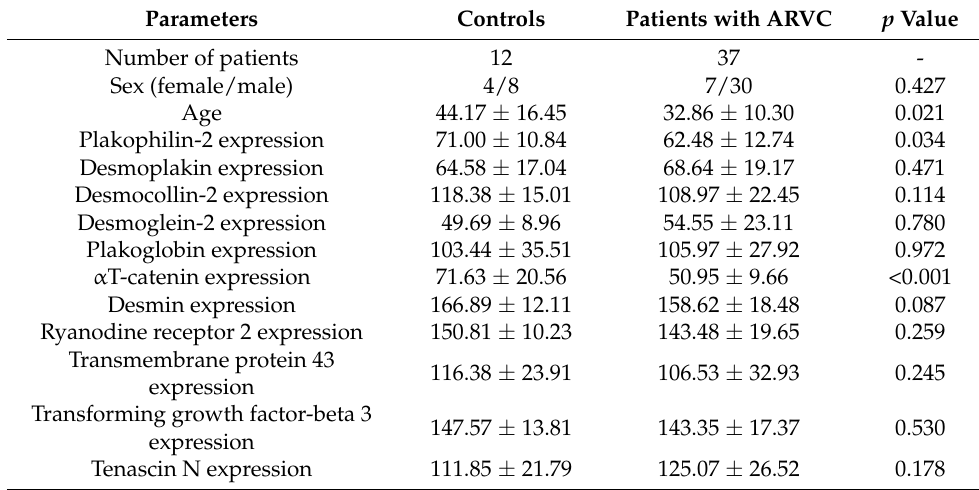
Table 1. Parameters of RV specimens collected from autopsied